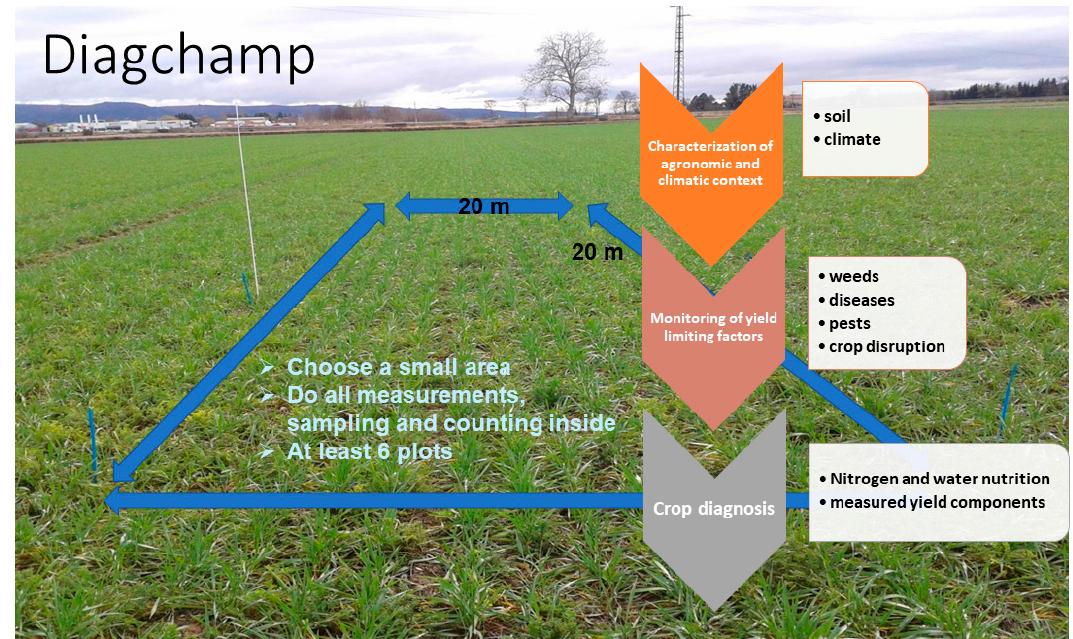
Figure 4. Diagchamp method scheme.